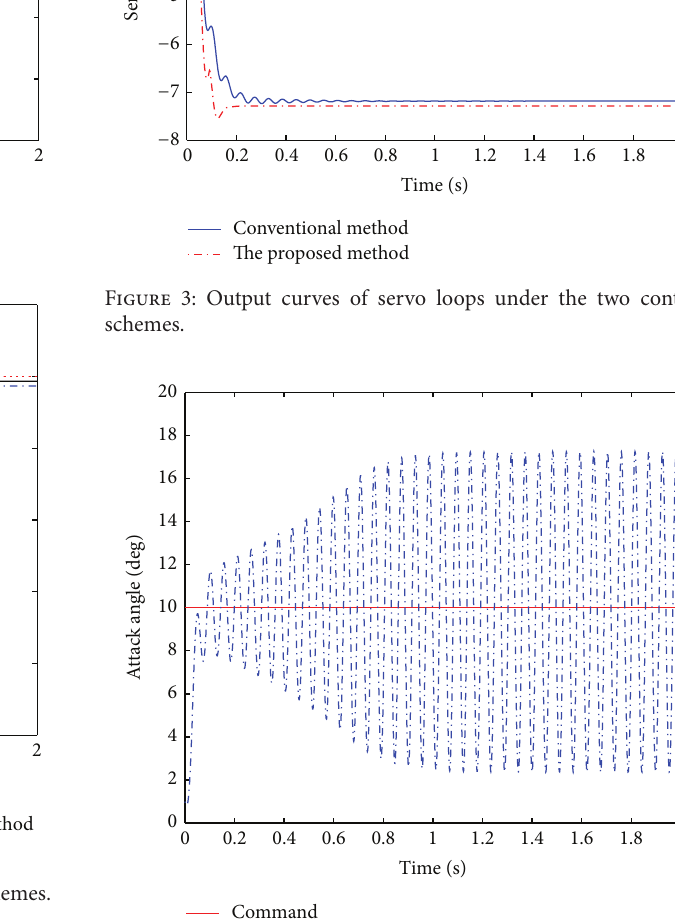
the scheme design, the response speed of attack angle is faster, and the stable tacking errors are smaller.